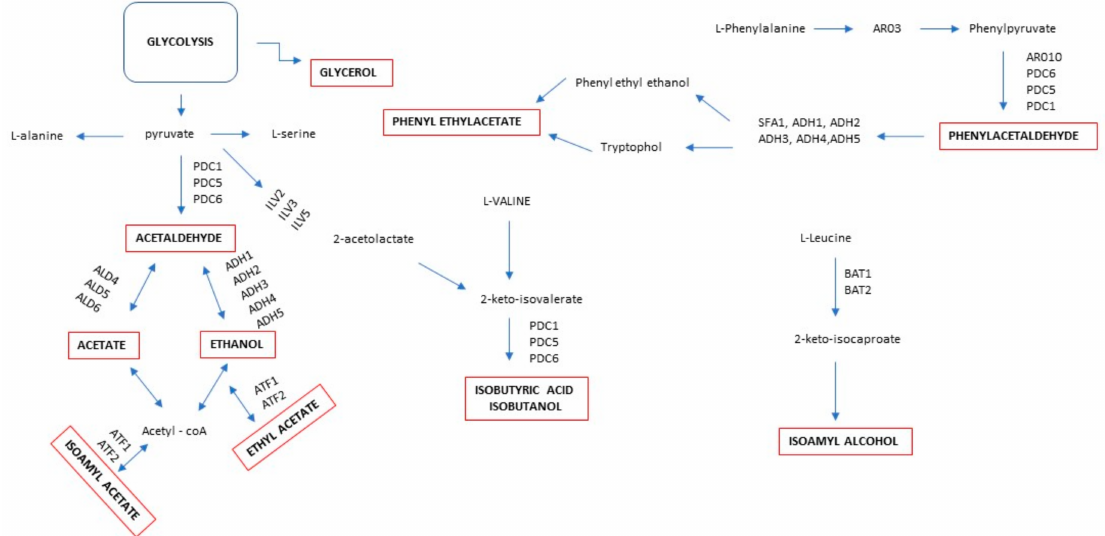
Figure 2. The main metabolic pathway involved in the production of aroma compounds. PDC1, PDC5, and PDC6 genes coding pyruvate decarboxylase; ALD4, ALD5, and ALD6 genes coding aldehyde dehydrogenase; ADH1, ADH2, ADH3, ADH4, and ADH5 genes coding alcohol dehydrogenase; ATF1 and ATF2 genes coding alcohol acetyl transferase; ILV2, ILV3, and ILV5 genes coding acetolactate synthase; AR03 and AR010 genes coding phenyl pyruvate and phenyl acetaldehyde; SFA1 synonyms of ADH5; BAT1 and BAT2 gene coding the mitochondrial-targeting